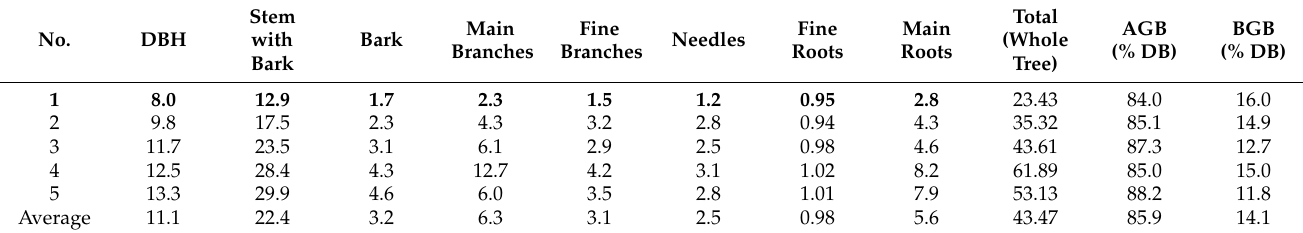
Table 1. Dry Biomass (DB) of the above- (AGB) and belowground (BGB) components of the five model trees (kg). No.